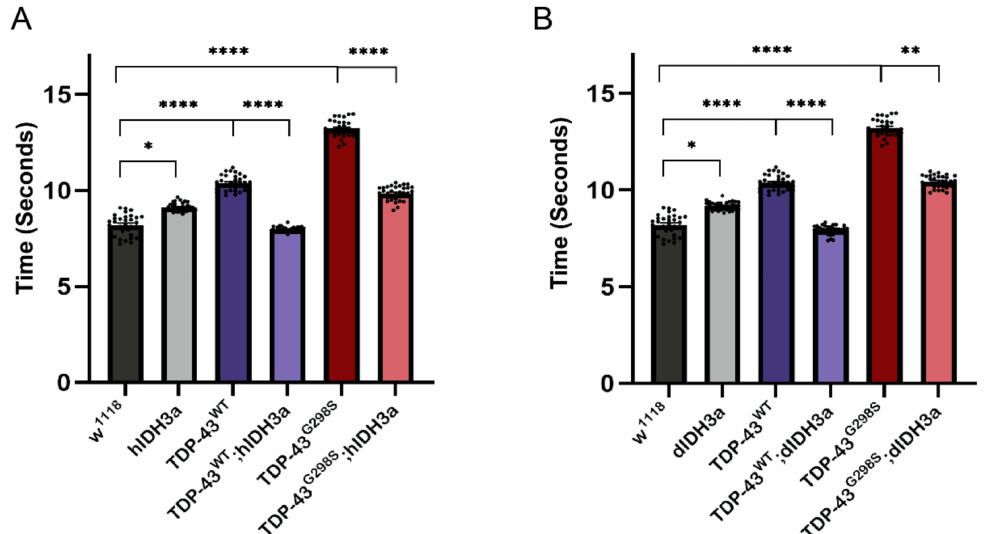
Figure 2. Overexpression of IDH3a rescues TDP-43 induced locomotor defects. ( A ) Larval turning times of larvae expressing human IDH3a (hIDH3a), TDP-43 WT , or TDP-43 G298S , individually or together, as indicated. ( B ) Larval turning times of larvae expressing Drosophila IDH3a (dIDH3a), TDP-43 WT , or TDP-43 G298S , individually or together, as indicated. n = 30 larvae per genotype. Kruskal–Wallis was used to determine statistical significance. *— p -value < 0.05, **— p -value < 0.01, ****— p -value <